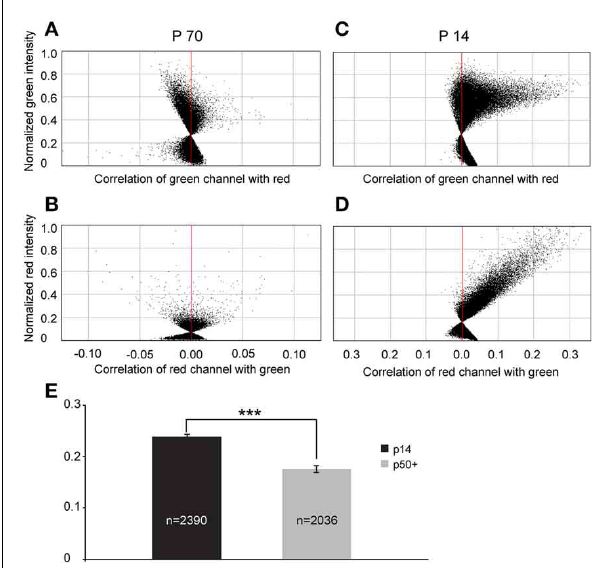
FIGURE 11 | Intrasomatic labeling against GAD67 in glycinergic VNTB neurons declines with age. (A–D) show pixel data from two single glycinergic VNTB neurons. Single glycinergic VNTB neurons were selected in a region of interest and analyzed for co-localization of signals in both channels. (A,B) display the normalized intensity correlation values of pixels in a p70 animal for the green and the red channel, respectively. Most of the values do not exceed the intensity correlation quotient (ICQ) range of − 0.05 to 0.05 and are mostly distributed around the midline, indicating a largely uncorrelated or random distribution of overlapping green and red pixels (the resulting total ICQ was − 0.001 in this case). By contrast, (C,D) show a strongly positive correlation of signals in the green and the red channels, respectively (with a resulting total ICQ value of 0.38 for this specific neuron). (E) Averaged total ICQ values for 2390 glycinergic VNTB neurons in p14 animals (black) and 2036 glycinergic VNTB neurons in p50 + (p59–70; gray) animals, respectively. ∗∗∗ p < 0 . 001 (Mann-Whitney rank-sum